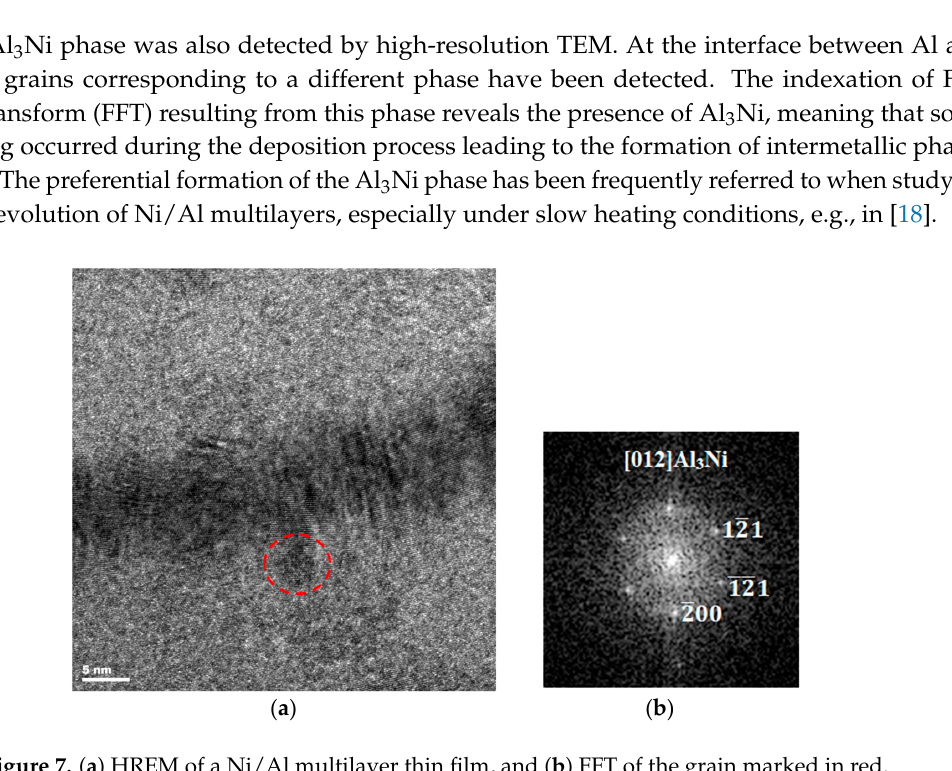
Figure 6. SAD patterns and respective diffraction spectra corresponding to ( a ) a defect-free region, and ( b ) the region marked in red in Figure 3.